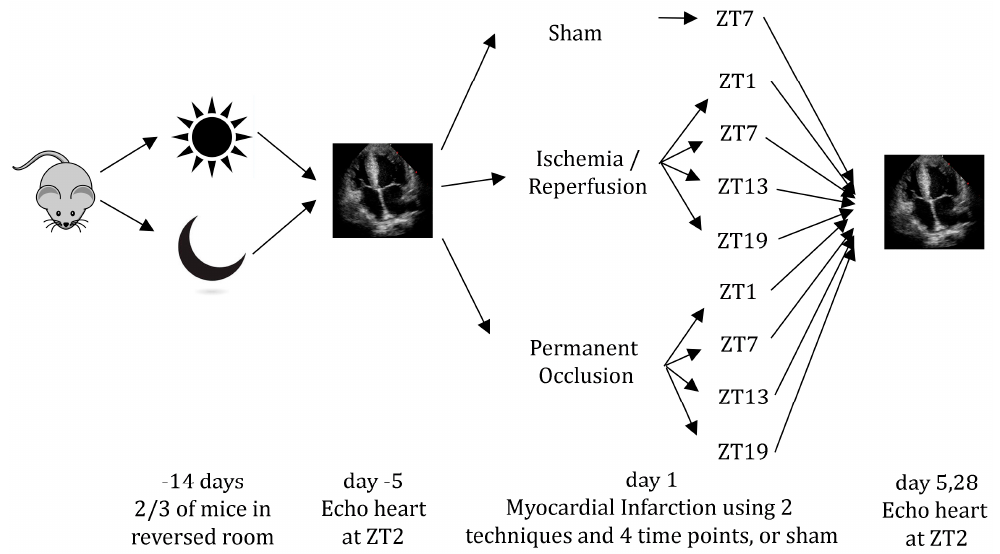
Figure 5. Overview of the procedure. Two-thirds of all mice were placed in rooms with altered light/dark regimes. Five days before the procedure, baseline echocardiography was performed. On Day 1, myocardial infarction (or sham) was induced at four different time-points using two different techniques. At 5 and 28 days, outcome was measured using echocardiography. ZT: Zeitgeber Time (ZT0 = lights on).